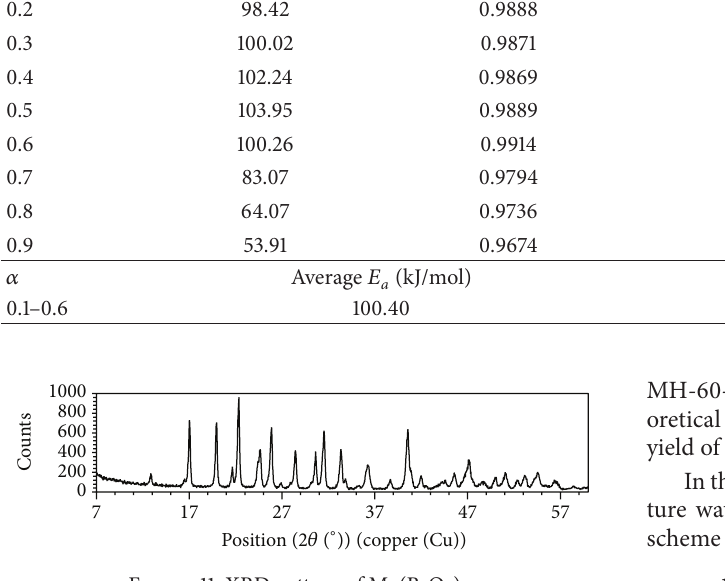
Figure 11: XRD pattern of Mg(B 2 O 3 ) 2